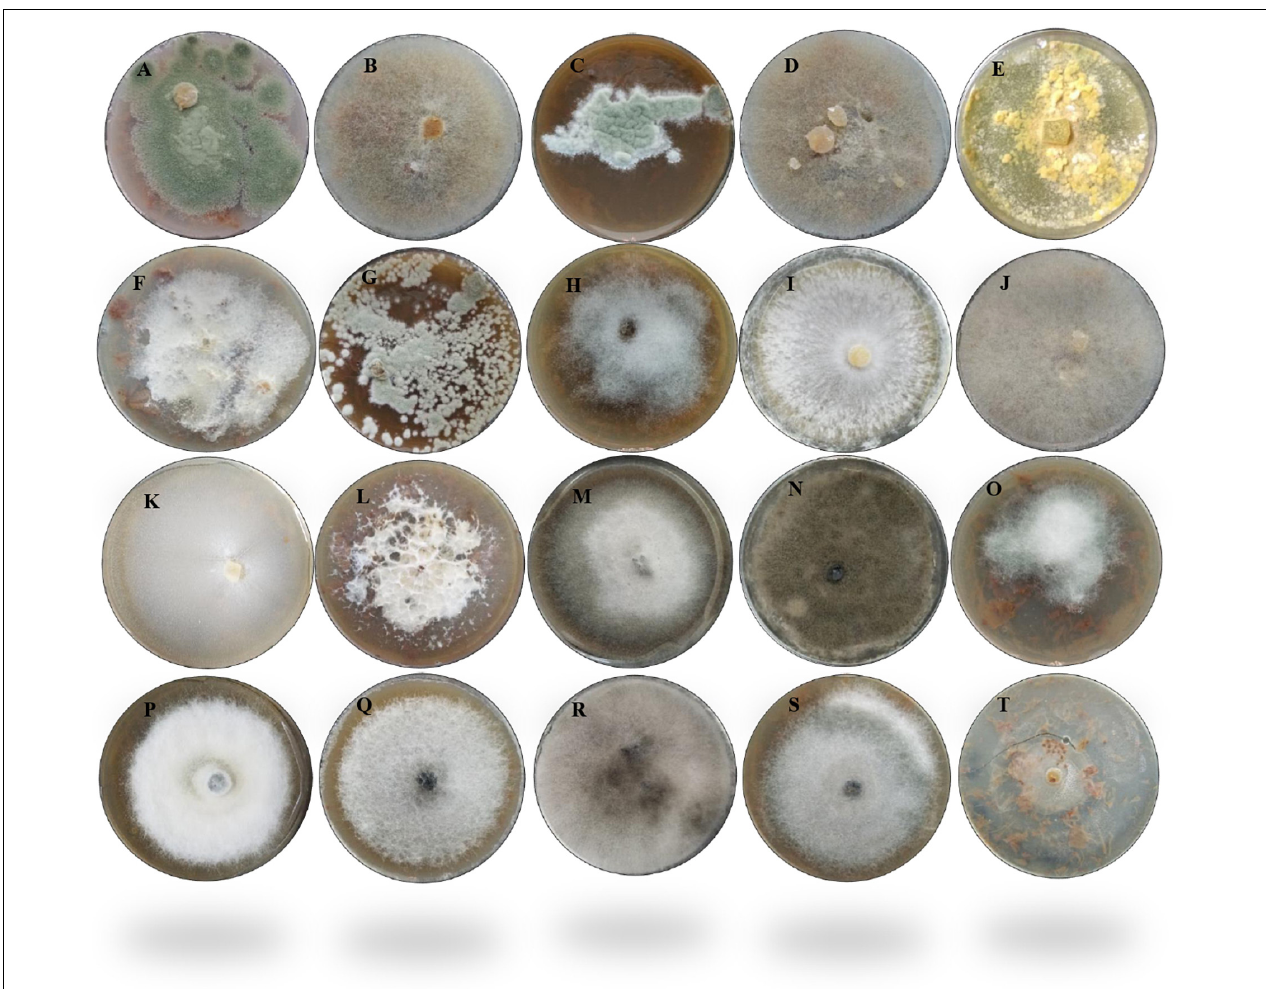
FIGURE 2 | Morphological appearance of the 20 fungal strains isolated from fruit berries. (A) Penicillium crustosum 1F. (B) Mucor circinelloides 1BF. (C) Penicillium expansum 230. (D) Mucor fragilis 22. (E) Trichoderma sp. 4AF. (F) Fusarium brachygibbosum 4BF. (G) Penicillium expansum 5F. (H) Botrytis sp. 62C. (I) Botrytis cinerea 62BCV. (J) Mucor fragilis FRA. (K) Geotrichum candidum FRB. (L) Fusarium brachygibbosum HBF. (M) Alternaria alternata 1A. (N) Cladosporium sp. 1BOA. (O) Alternaria alternata 2Z. (P) Alternaria sp. 3A. (Q) Alternaria alternata 4A. (R) Botryosphaeria rhodina 5A. (S) Alternaria alternata 6A. (T) Geotrichum phurueaensis 7Z. The fungal growth was observed at different times, ranging from 5 to 8